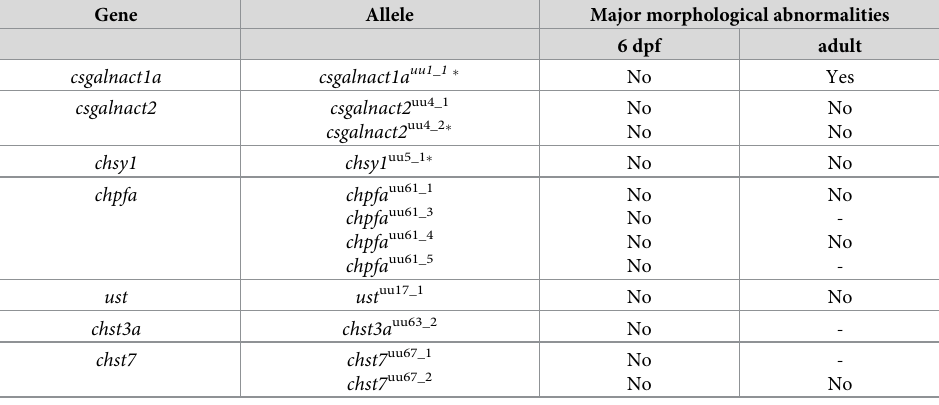
Table 2. Homozygous mutants survive into adulthood . List of identified alleles and observed general morphology phenotypes at 6 dpf and in adults. (-) = not determined. � In this paper referred to as csgalnact1a -/- , csgalnact2 -/- and chsy1 -/- ,